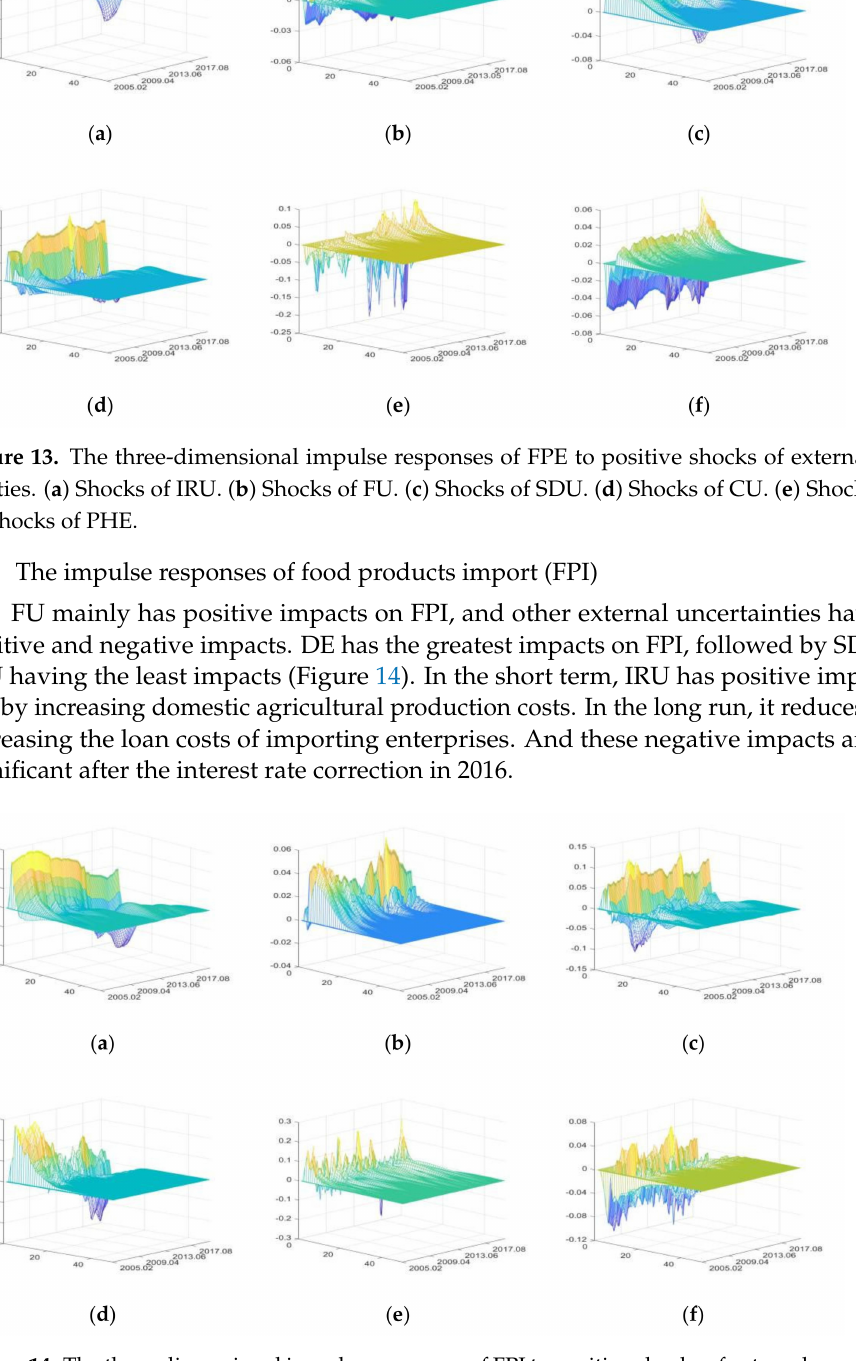
Figure 14. The three-dimensional impulse responses of FPI to positive shocks of external uncertainties. ( a ) Shocks of IRU. ( b ) Shocks of FU. ( c ) Shocks of SDU. ( d ) Shocks of CU. ( e ) Shocks of DE. ( f ) Shocks of